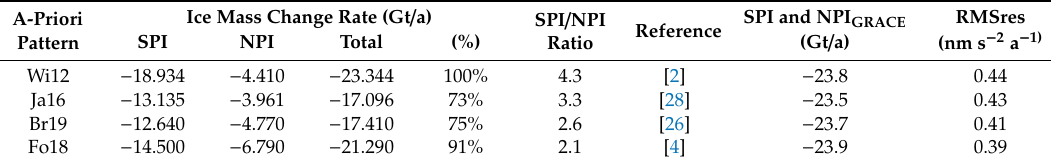
Table A1. A-priori ice mass change rate patterns used to adjust GRACE gravity rate vectors. Ice Mass Change Rate (Gt / a) SPI / NPI A-Priori Pattern